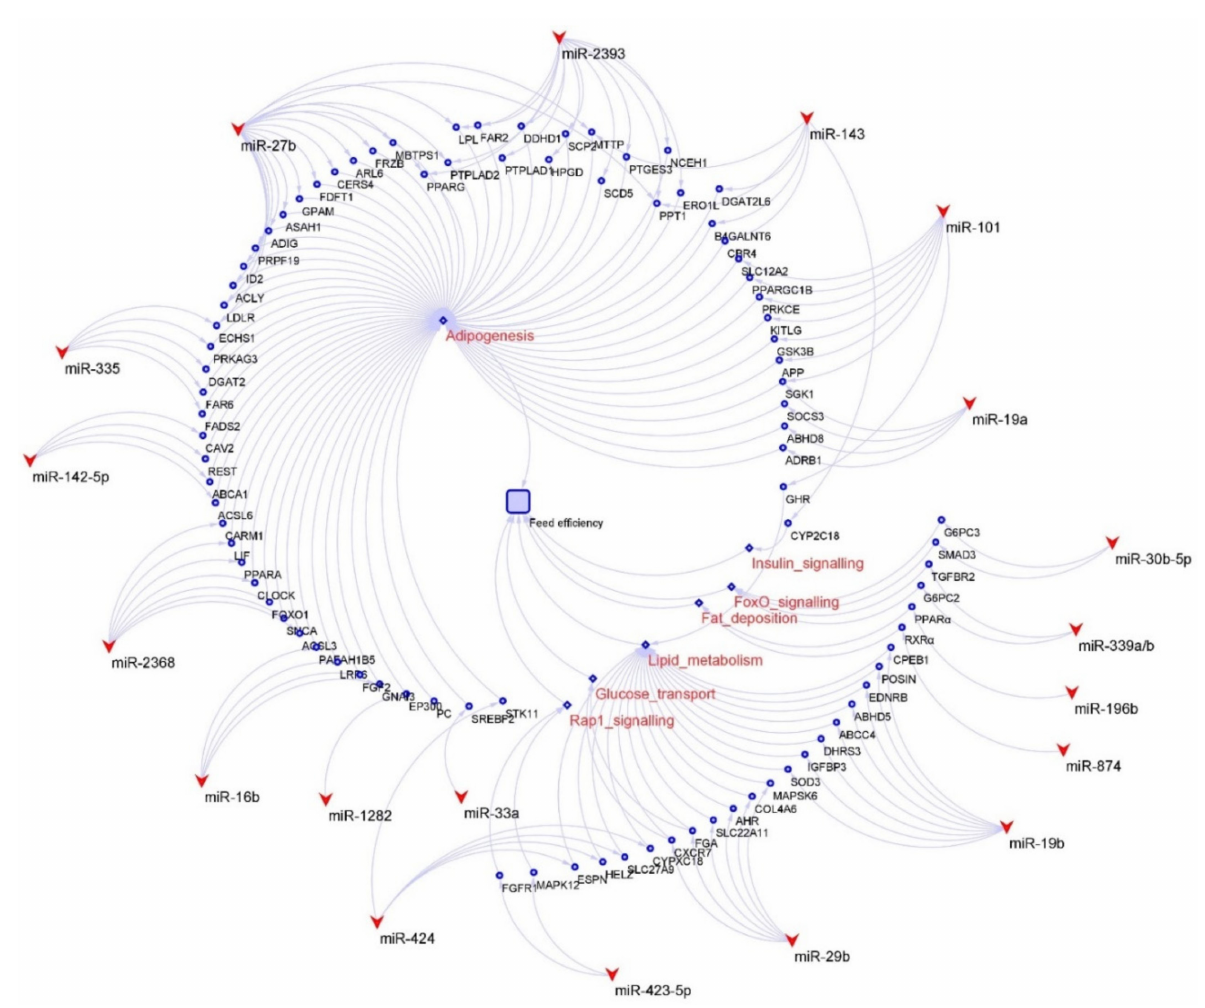
Figure 2. Candidate miRNAs and related genes and pathways for feed efficiency in cattle. The round shapes indicate genes, the diamond shapes show the pathways, and the V shapes indicate